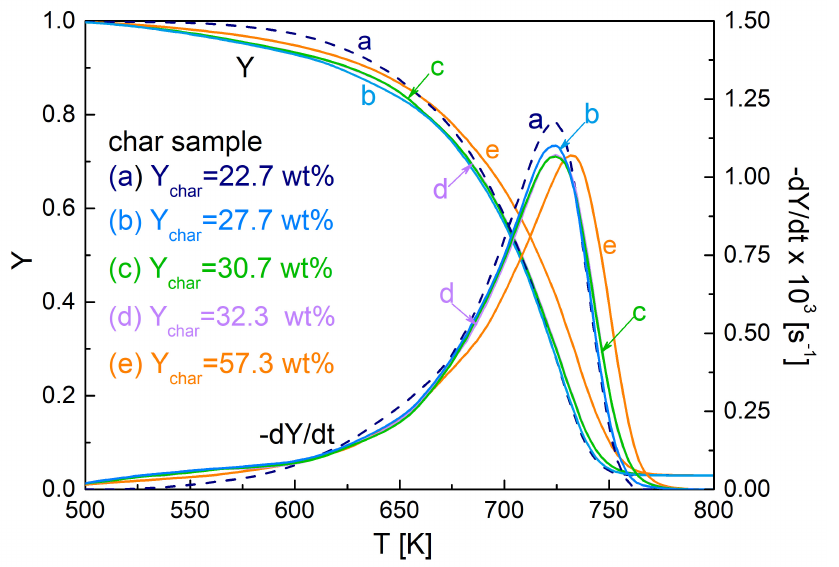
Figure 1. Weight loss curves (Y) and devolatilization rate curves ( − dY/dt) as functions of temperature for the oxidation of fixed-bed chars produced at 800 K, from untreated and torrefied spruce wood (torrefaction conditions in Table 1) measured for a heating rate of 5 K/min.